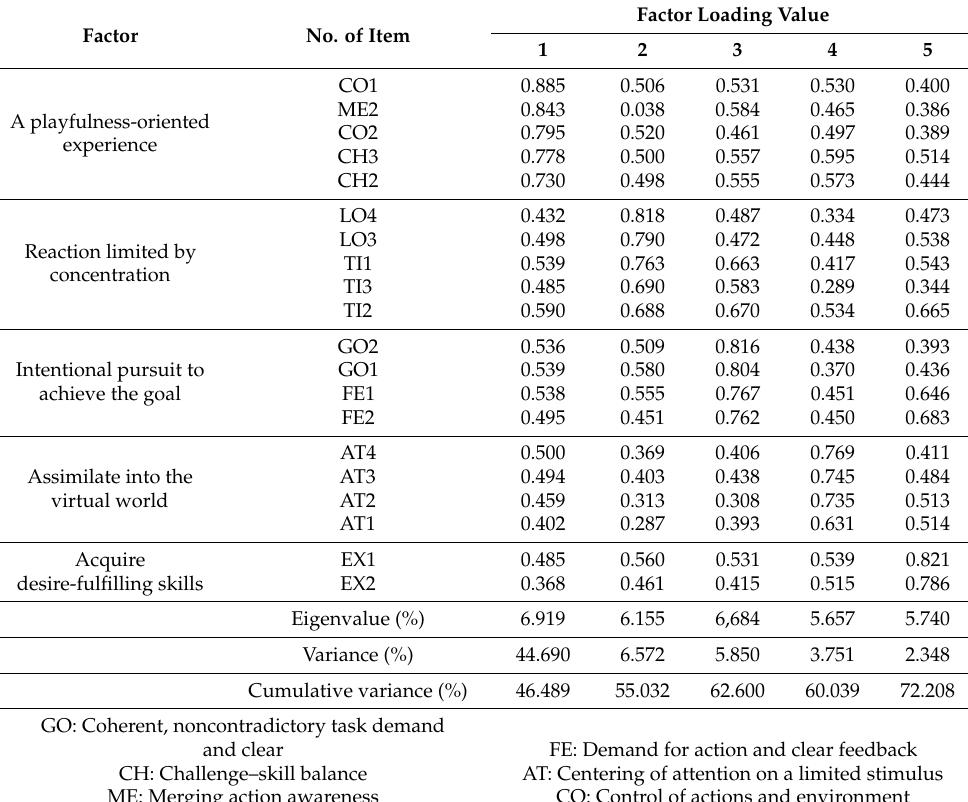
Table 3. Loading of TS-FSS items in the exploratory factor analysis ( n =